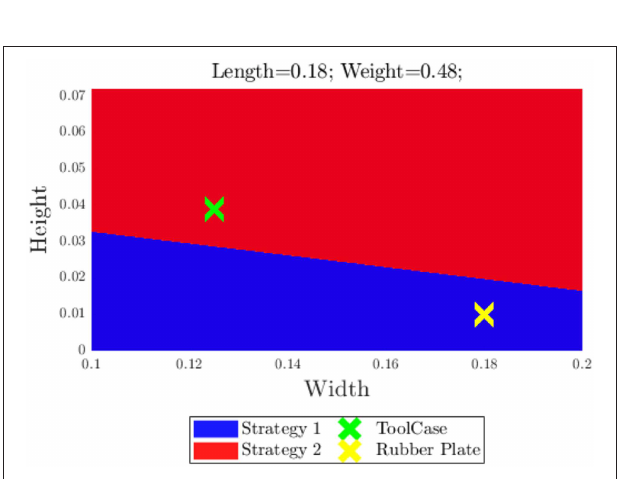
FIGURE 13 | Results of the Naive Bayes classifier for different pairs of features.